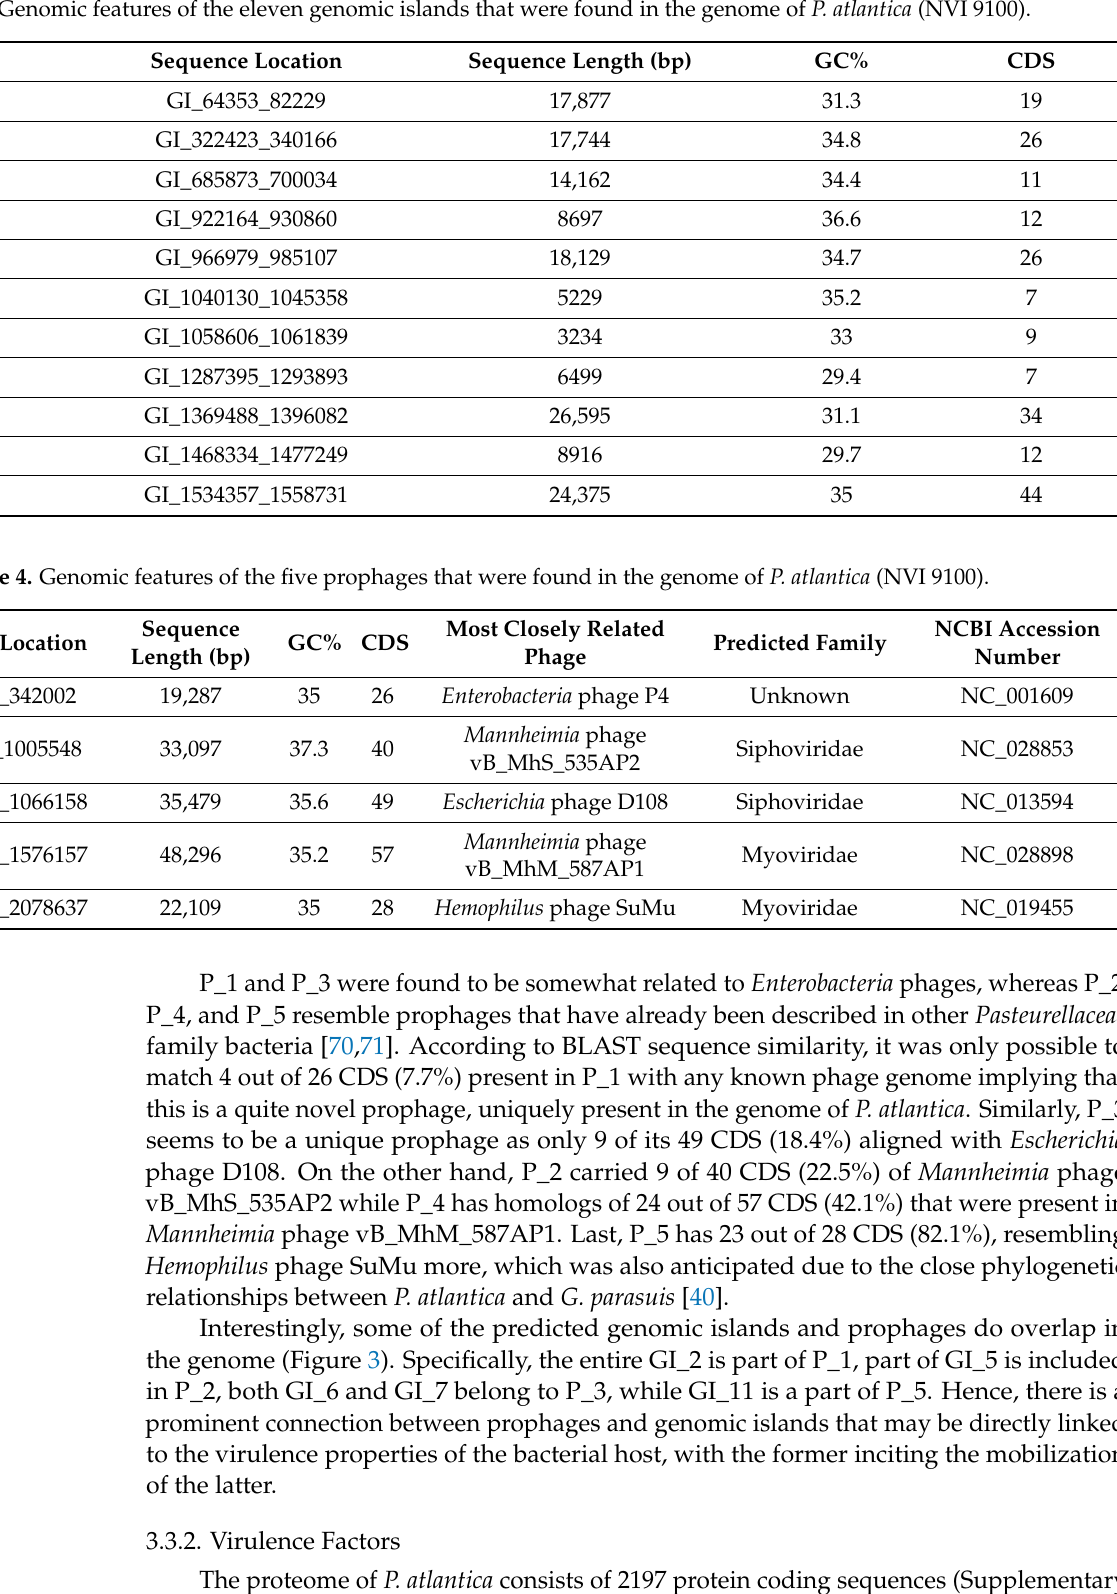
Table 3. Genomic features of the eleven genomic islands that were found in the genome of P. atlantica (NVI 9100).